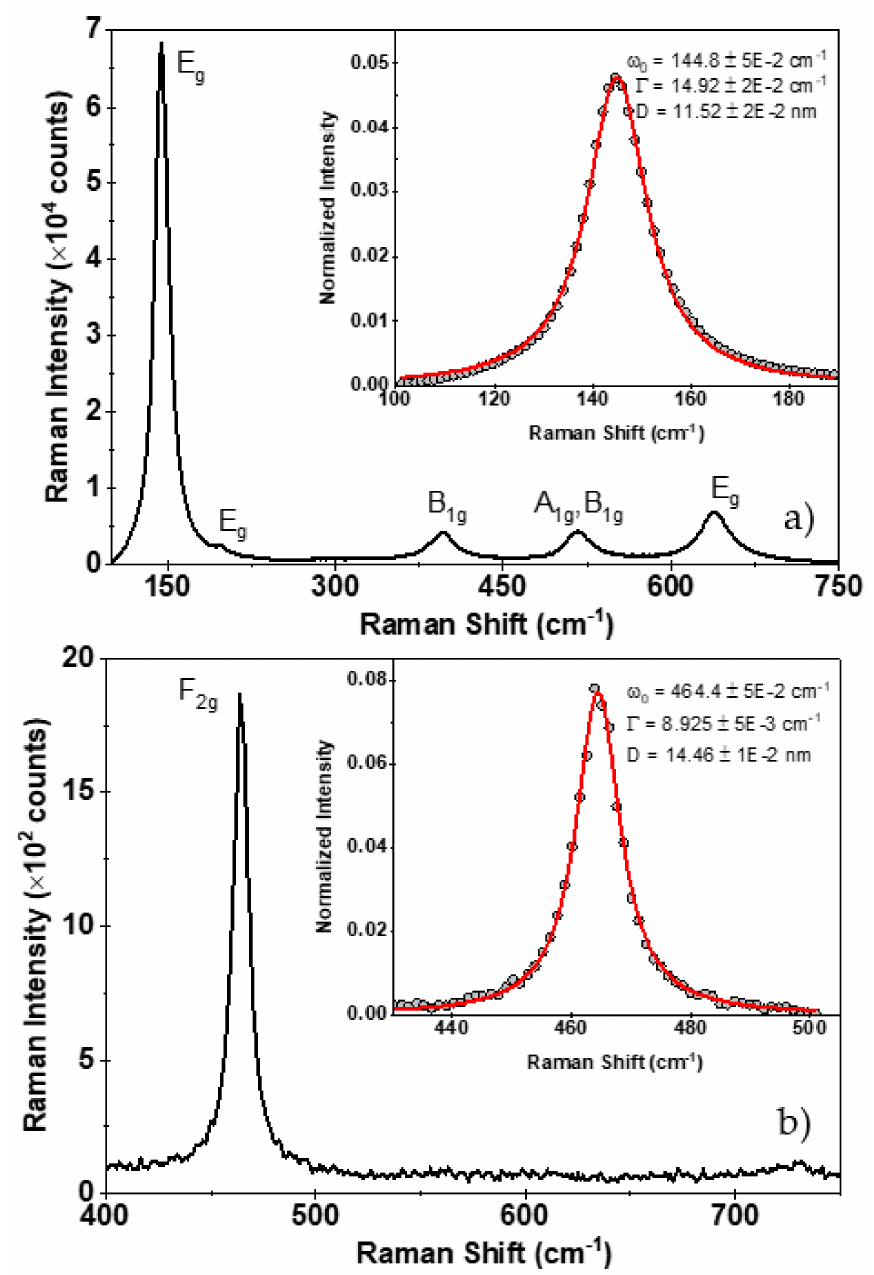
Figure 6. Raman spectrum of TiO 2 ( a ) and CeO 2 ( b ) nanopowders, respectively. Inset graphs denote the fit after Equation (25). Best fitted parameters are